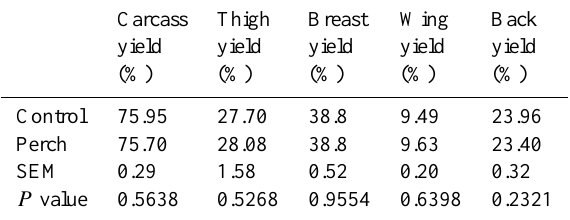
Table 3. Effects of perch availability on carcass characteristics of